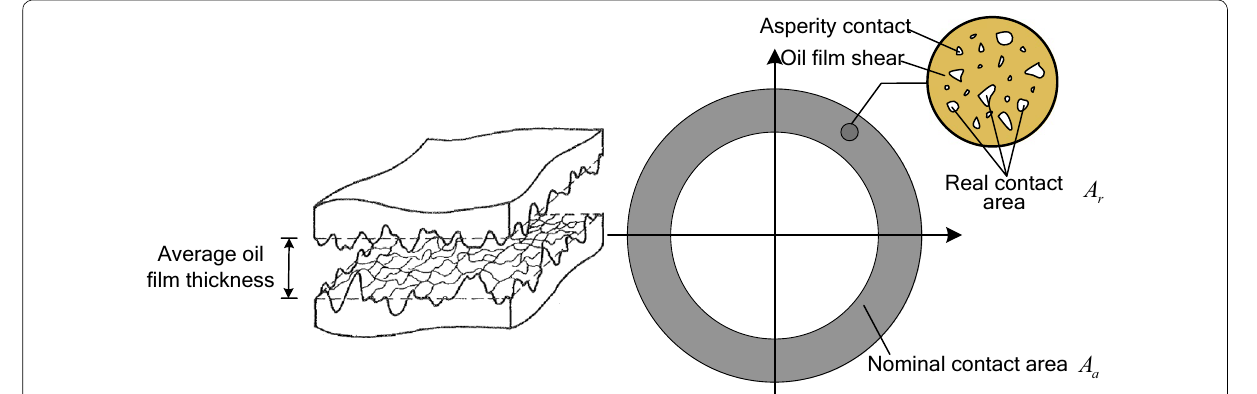
Figure 2 Schematic diagram of mixed friction stage